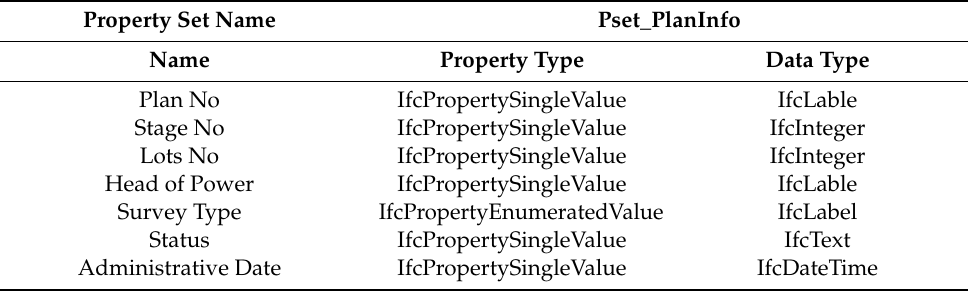
Table 5. Proposed property set for incorporating plan information into